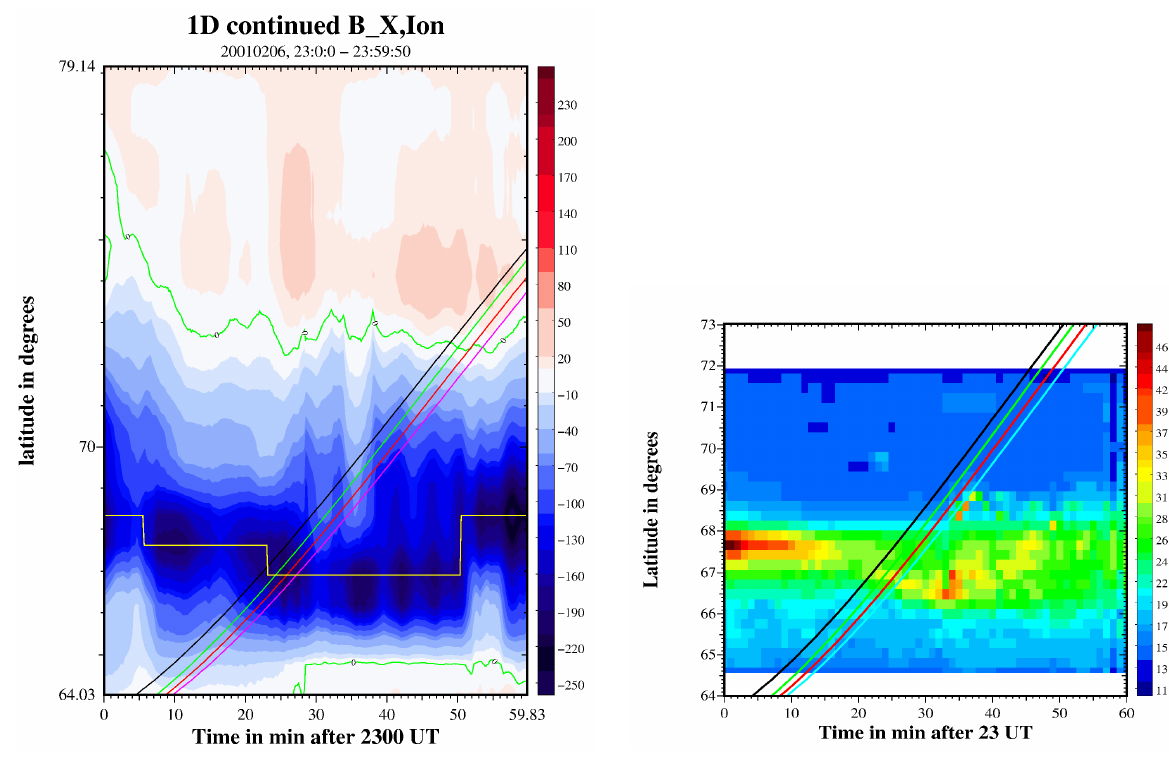
Fig. 3. Left panel: results of the 1-D upward continuation of the north component of the ground magnetic field towards the ionospheric level, in nT. For each time step, a meridional profile is shown. Negative numbers indicate a westward (equivalent) electrojet, positive numbers eastward (equivalent) currents. The border between these currents defines the magnetic convection reversal boundary (MCRB; green line). The peak location of the westward electrojet is schmatically indicated by the yellow line. The magnetic footprints of the Cluster II satellites are indicated with lines of colours as in Fig. 1. Right panel: Keogram of all-sky camera data from the station Abisko (ABK); the panel is placed such that latitudes correspond approximately to the one of the right panel, but only exactly at the zenith of